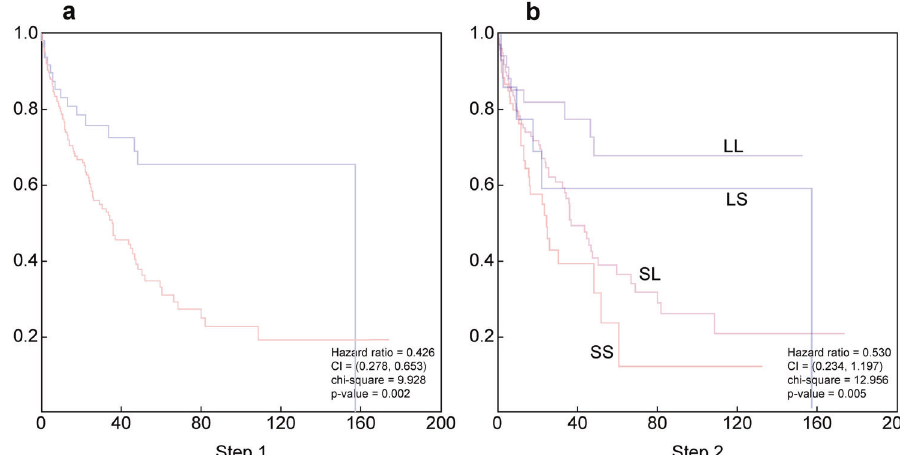
Fig. 3 Validation of the machine learning models using independent set of 247 extranodal DLBCL samples. a Overallsurvival using two groups model and b overall survival using four groups